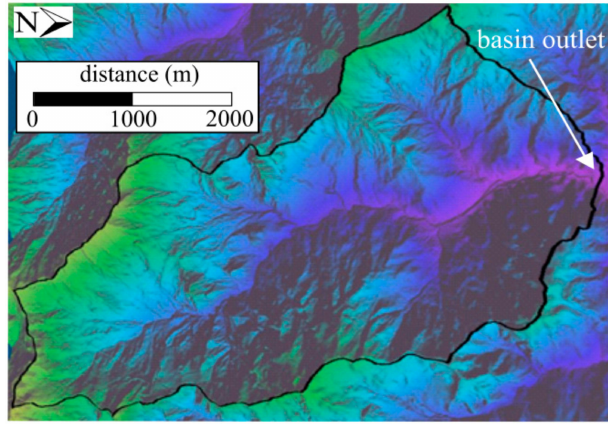
Figure 1. Scuropasso